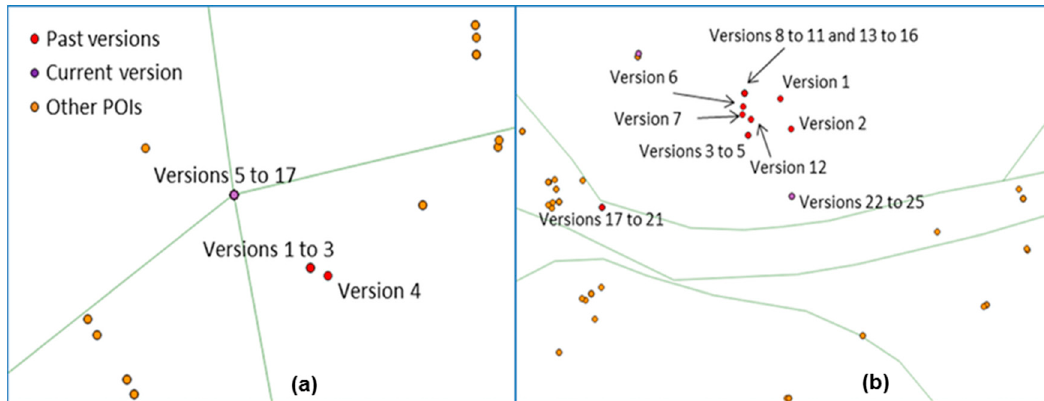
Figure 17. Two examples of the evolution of subway station location: ( a ) the station is put at the intersection of the subway lines in version 5 and then never moves (only tags are then modified); ( b ) the current version is still wrongly located, and we can see many displacements due to contributor disagreements, as 17 contributors edited this feature (©OpenStreetMap contributors).